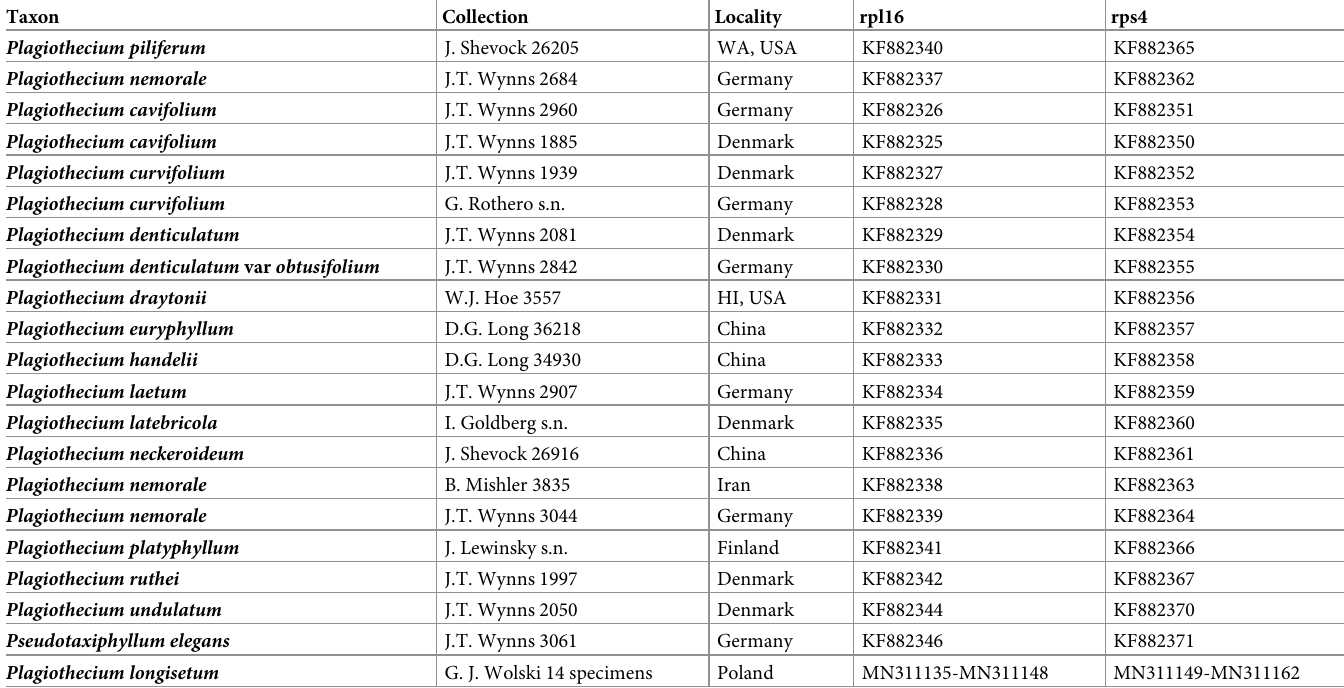
Table 3. Voucher information and accession numbers for the specimens included in the phylogenetic analysis of chloroplast